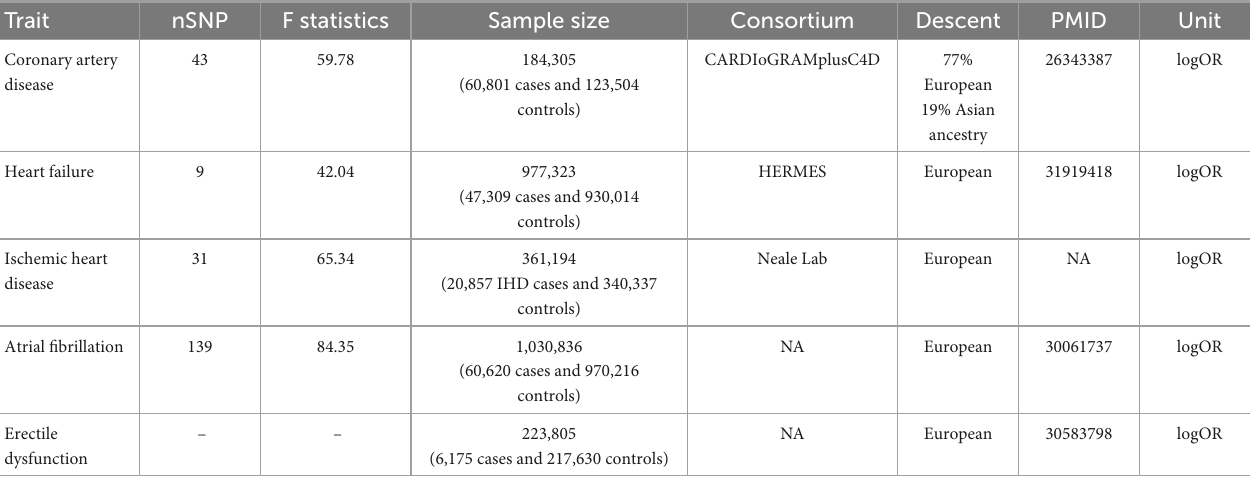
TABLE 1 Characteristics of included